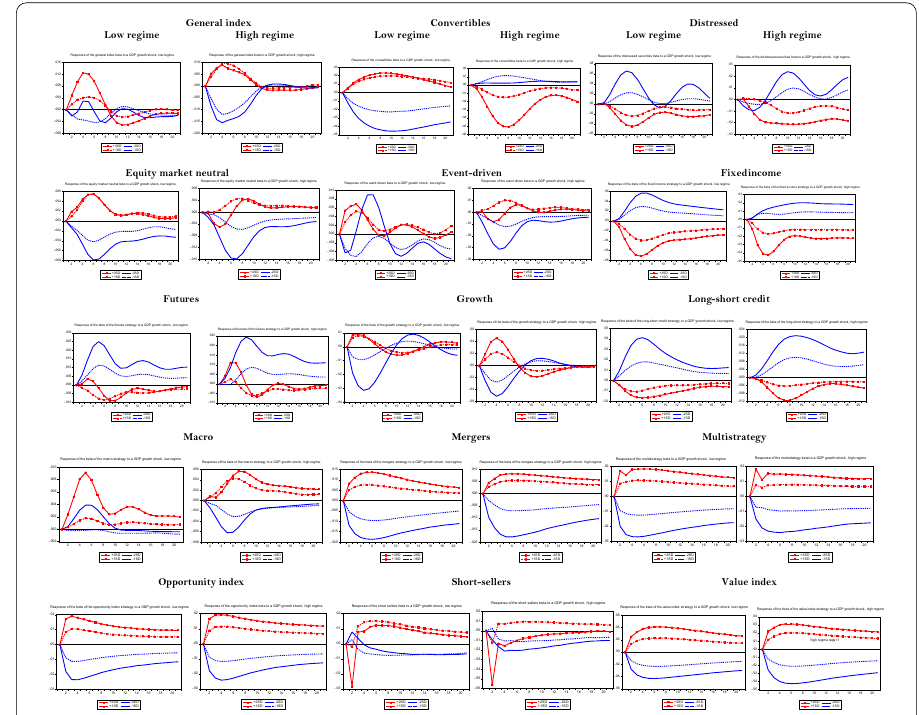
Fig. 10 Response of hedge fund beta to a moderate and strong negative and positive GDP growth shocks in low and high regimes, general index and strategies. Notes: These plots correspond to the impulse response functions of strategies’ betas to GDP growth shocks. They are built with the Balke’s (2000) nonlinear impulse response functions algorithm using the generalized impulse response function to identify structural shocks (Koop et al. 1996; Pesaran and Shin 1997, 1998). For each strategy, we have two kinds of shocks: positive and negative shocks of GDP growth, and moderate and strong shocks, corresponding to one and two standard deviations of the value of the shocks, respectively, for a total of four impulse response functions by regime for each strategy. Moreover, Balke (2000) considers two categories of regimes separated by an optimal threshold value: a low and a high regime. The significance of the threshold values is evaluated with Wald